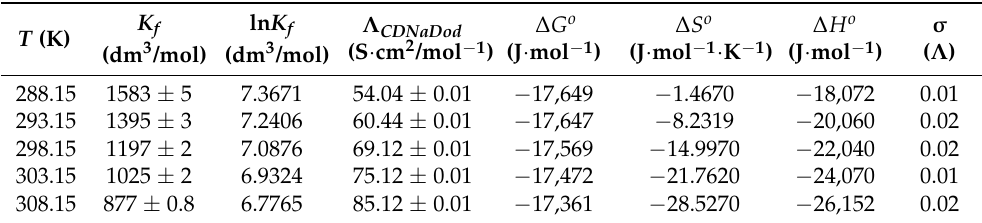
Table 3. The value of formation constant K f (dm 3 /mol), theoretical conductivity Λ CDNaDod (S · cm 2 /mol − 1 ) and the values of thermodynamic functions ∆ G o , ∆ H o and ∆ S o for α -cyclodextrin with the salt of trans - p -coumaric acid.